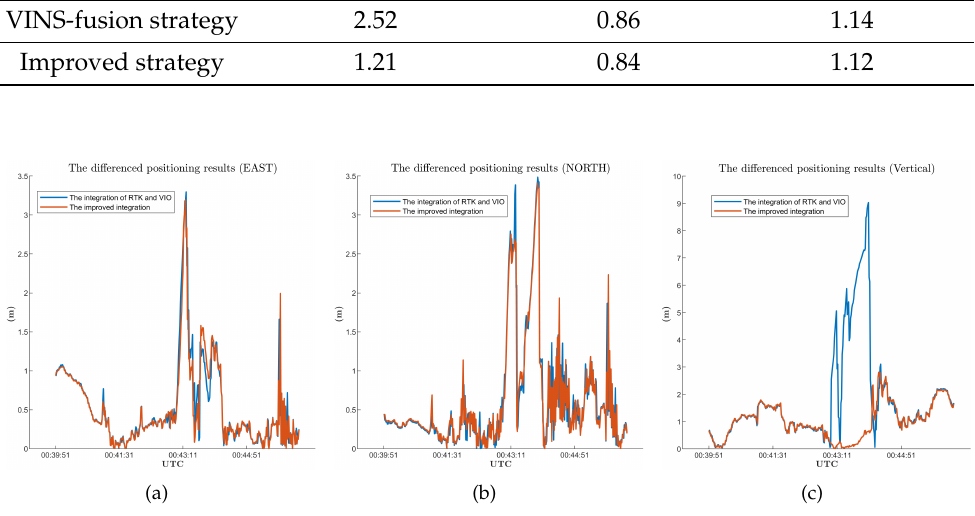
Figure 19. The differences between the reference and the integration results of different strategies. ( a ) The differences between the reference and the integration results in east. ( b ) The differences between the reference and the integration results in north. ( c ) The differences between the reference and the integration results in